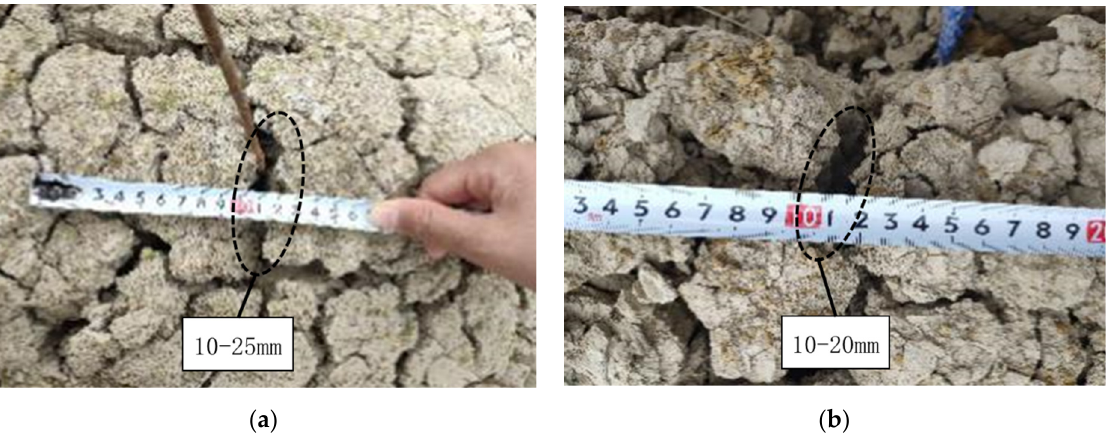
Figure 13. Slope fissure diagram: ( a ) test section on the 1:2 side slope; ( b ) test section on the 1:1.5 side slope.